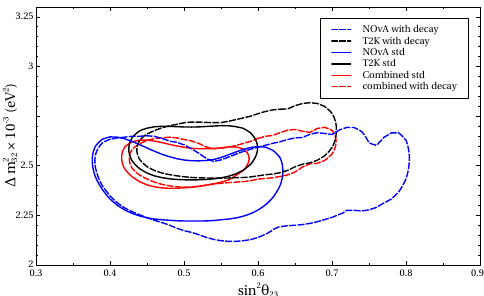
Figure 3 . The 95% C.L. allowed areas obtained in the sin 2 (cid:18) 23 (cid:0) (cid:1) m 2 T2K data (red lines), NOvA data (green lines) and T2K+NOvA data (black lines). The solid lines are for standard three-generation oscillations while the dashed lines are for oscillation with